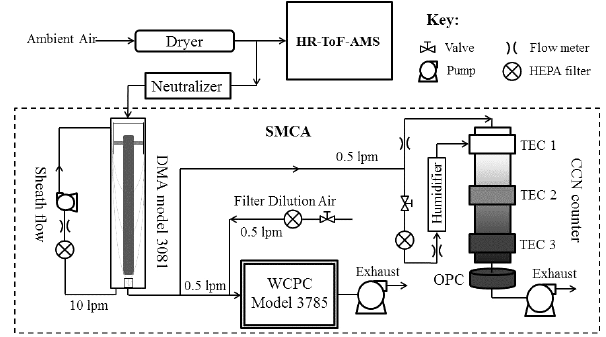
Figure 1. Schematic of the experimental setup for size-resolved CCN activation and chemical composition